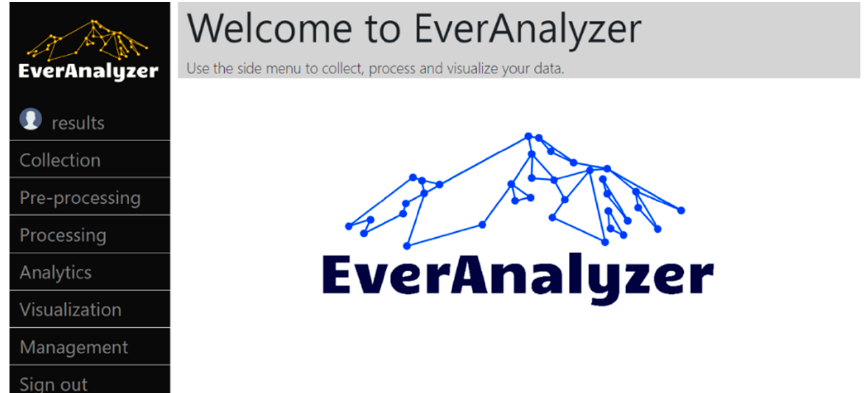
Figure 13. ( a ) Sign-in interface; ( b ) Sign-up interface.